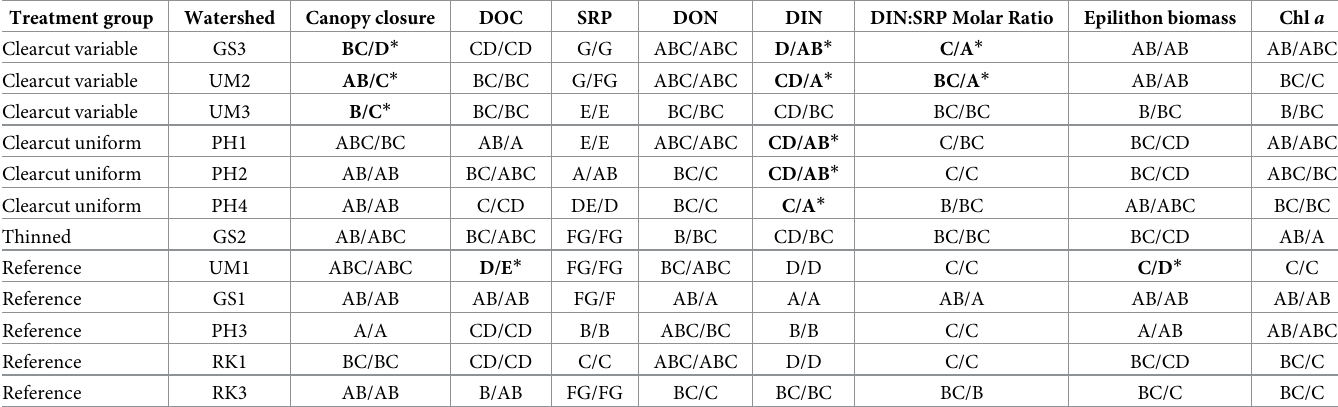
Table 3. Statistical summary from Partial Least Square models comparing pre- to post-harvest responses in headwater watersheds. Treatment